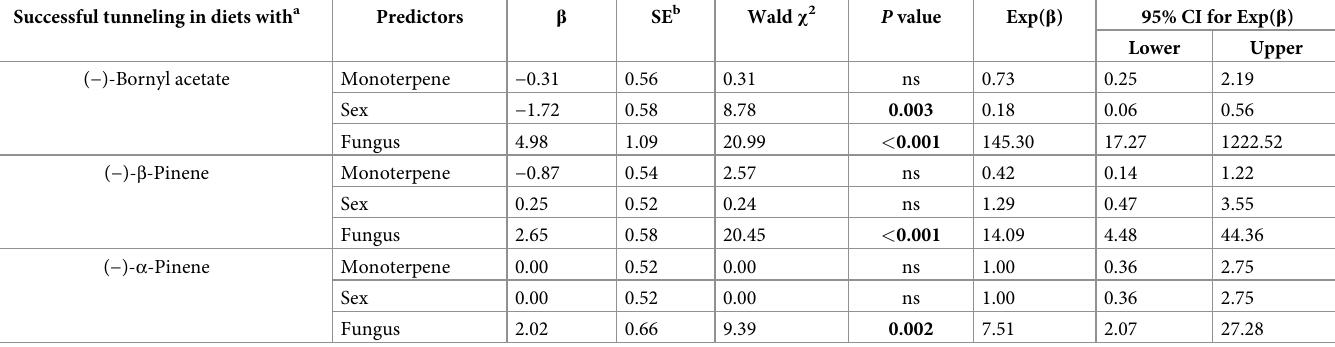
Table 1. Multiple logistic regression analysis predicting the odds of adult I . typographus tunneling into media enriched in different monoterpenes with and without G . penicillata in a no-choice assay (see also Fig 6A). The data underlying this Table can be found at